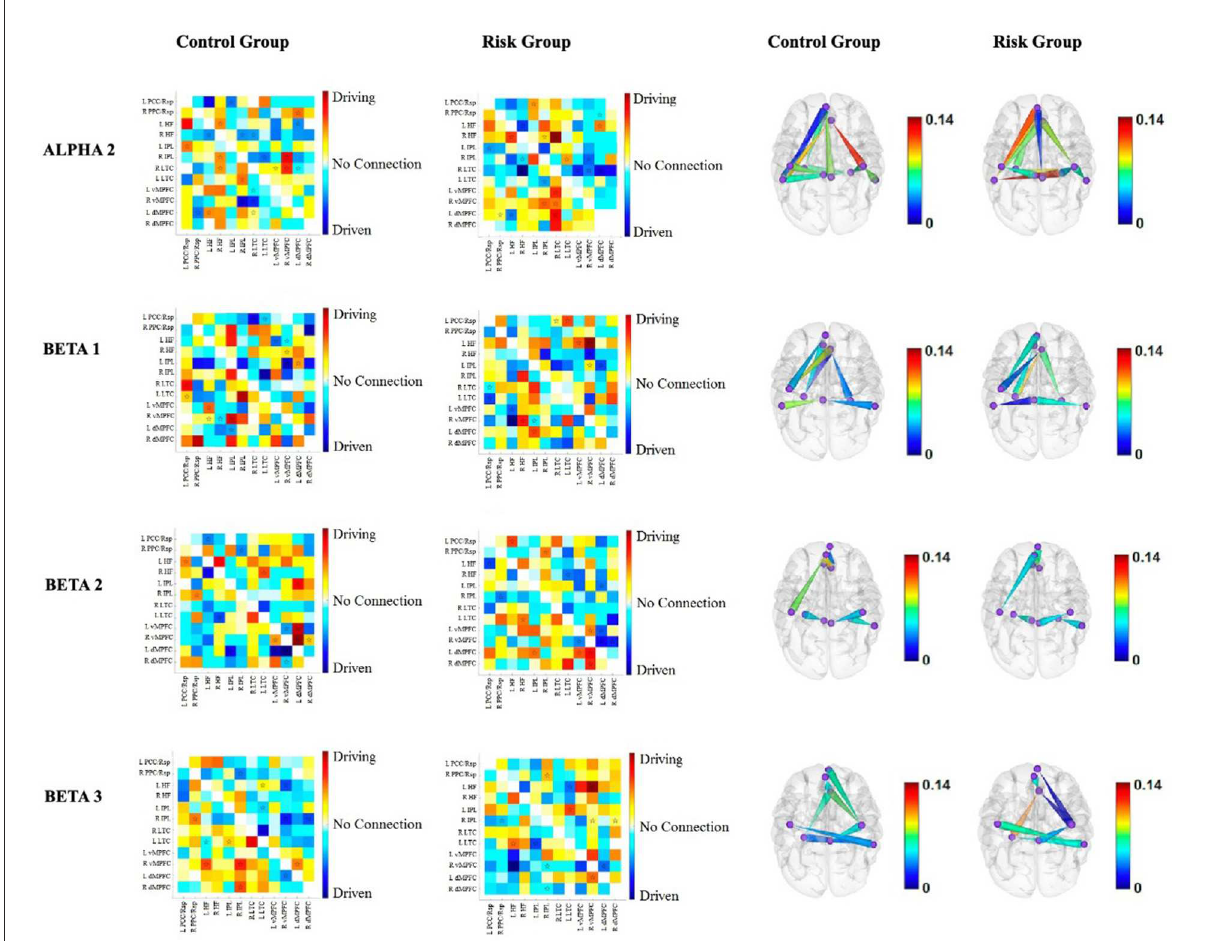
FIGURE5 Functional connectivity between the nodes of the DMN for each group for alpha2, beta1, beta2, and beta3. The first two columns correspond to the functional connectivity matrices of the CG and the RG, respectively. Warm colors indicate the driving nodes, and cool colors indicate the driven nodes. The connections that exceeded the probability threshold ( p = 0.05) are indicated with a star and are shown in the cortical maps of the last two columns. Direction is represented by the cones, with the vertices indicating the driven nodes and the bases indicating the driver nodes. The color scale illustrates the connectivity strength. The rows represent each frequency